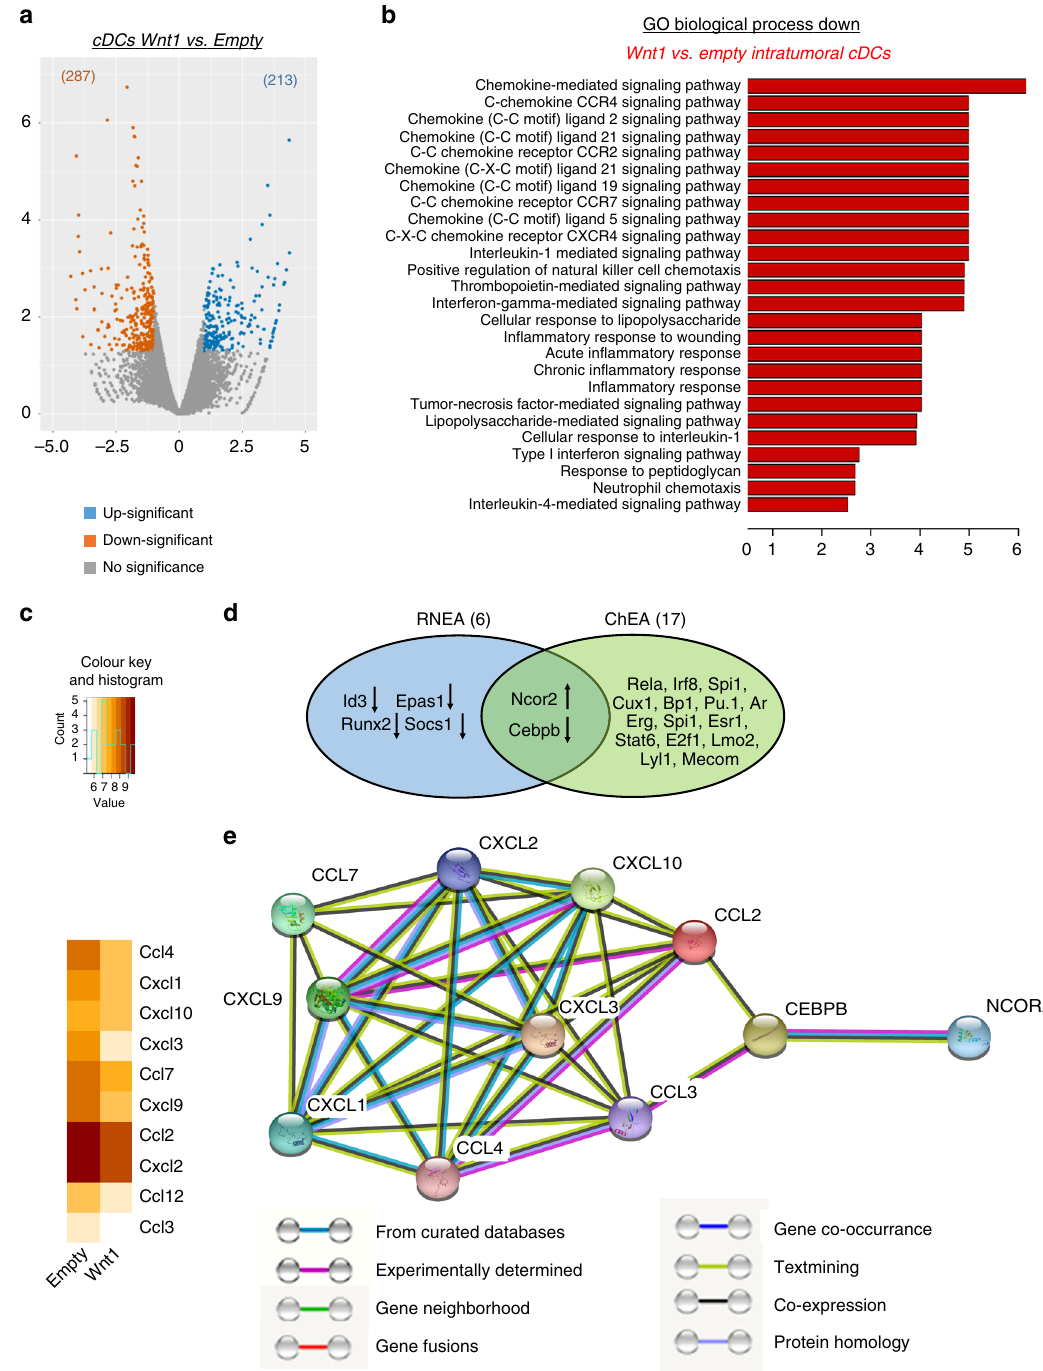
Fig. 5 Wnt1 represses chemokine genes on intratumoral DCs. a Volcano plot of differentially expressed genes (DEGs) in cDCs puri fi ed from Wnt1- overexpressing (Wnt1) vs control tumors (Empty). b Functional enrichment analysis (GO Biological Processes) of downregulated genes in Wnt1 vs. Empty tumor cDCs. c Expression heatmap (log2 normalized read counts) of differentially expressed chemokines. d Venn diagram of the overlap of predicted regulators by RNEA and ChEA. e String database interactions for differentially expressed chemokines, Ncor2 and Cebpb (network indicates evidence with medium con fi dence for all active interaction sources). Intratumoral lung cDCs were pooled from 3 – 4 mice ( n = 3 pooled samples per group). d Arrows indicate up or downregulation of the differentially expressed regulators in Wnt1 vs Empty tumor cDCs. Sequencing data are available with the accession code